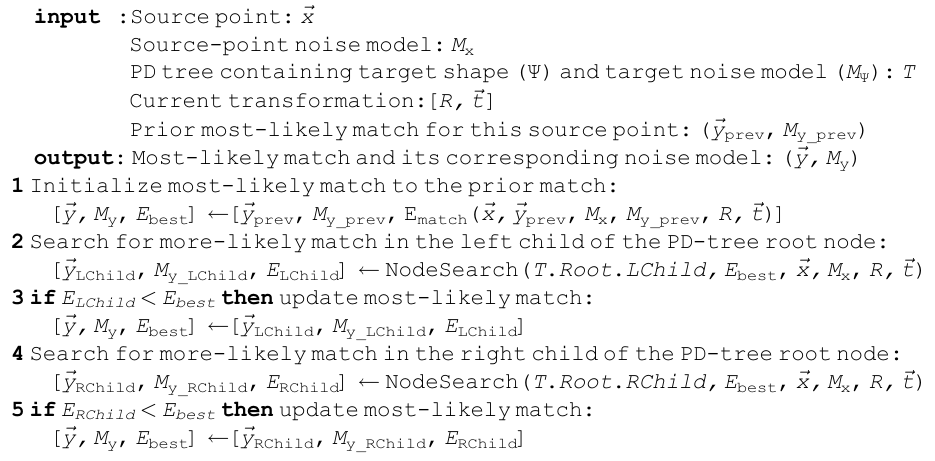
Algorithm 4. NodeSearch Function for the PD-Tree Search input :Node of PD tree being search: